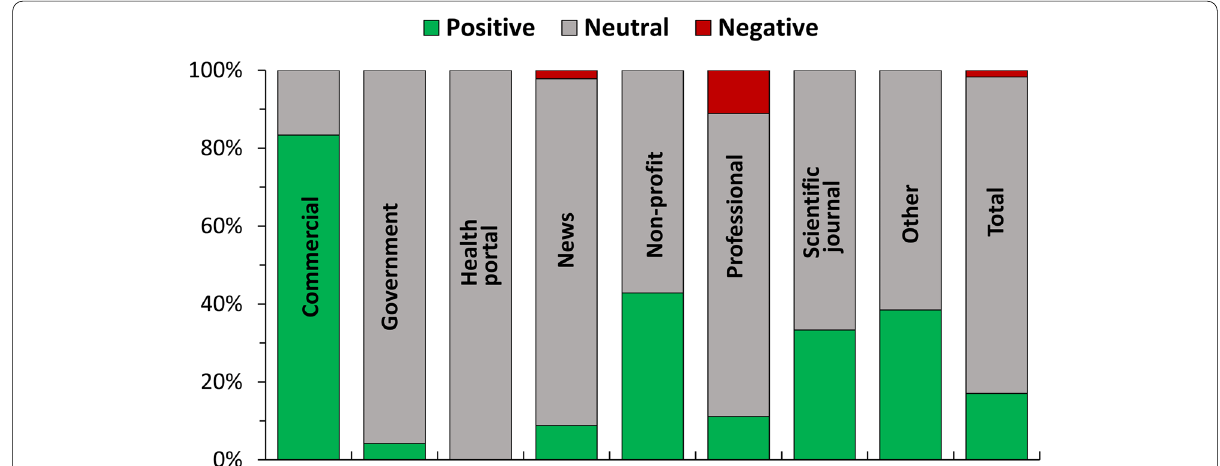
Fig. 4 Stance toward medical cannabis in different typologies of websites. Data represent the percentage of webpages with a specific stance on cannabis. C, commercial; G, government; HP, health portals; N, news; NP, no profit; P, professional; SJ, scientific journal; O, other